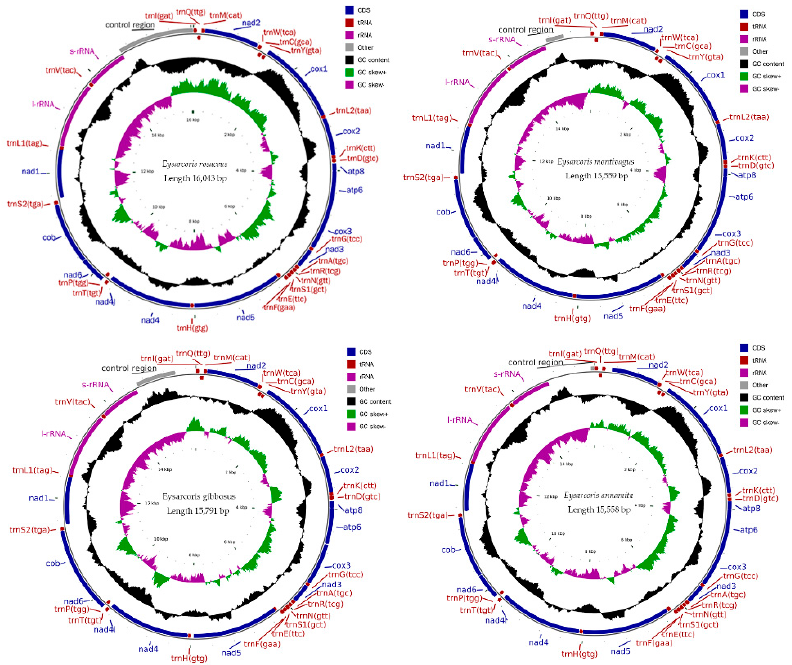
Figure 1. Gene arrangements of the four complete mitochondrial genomes.